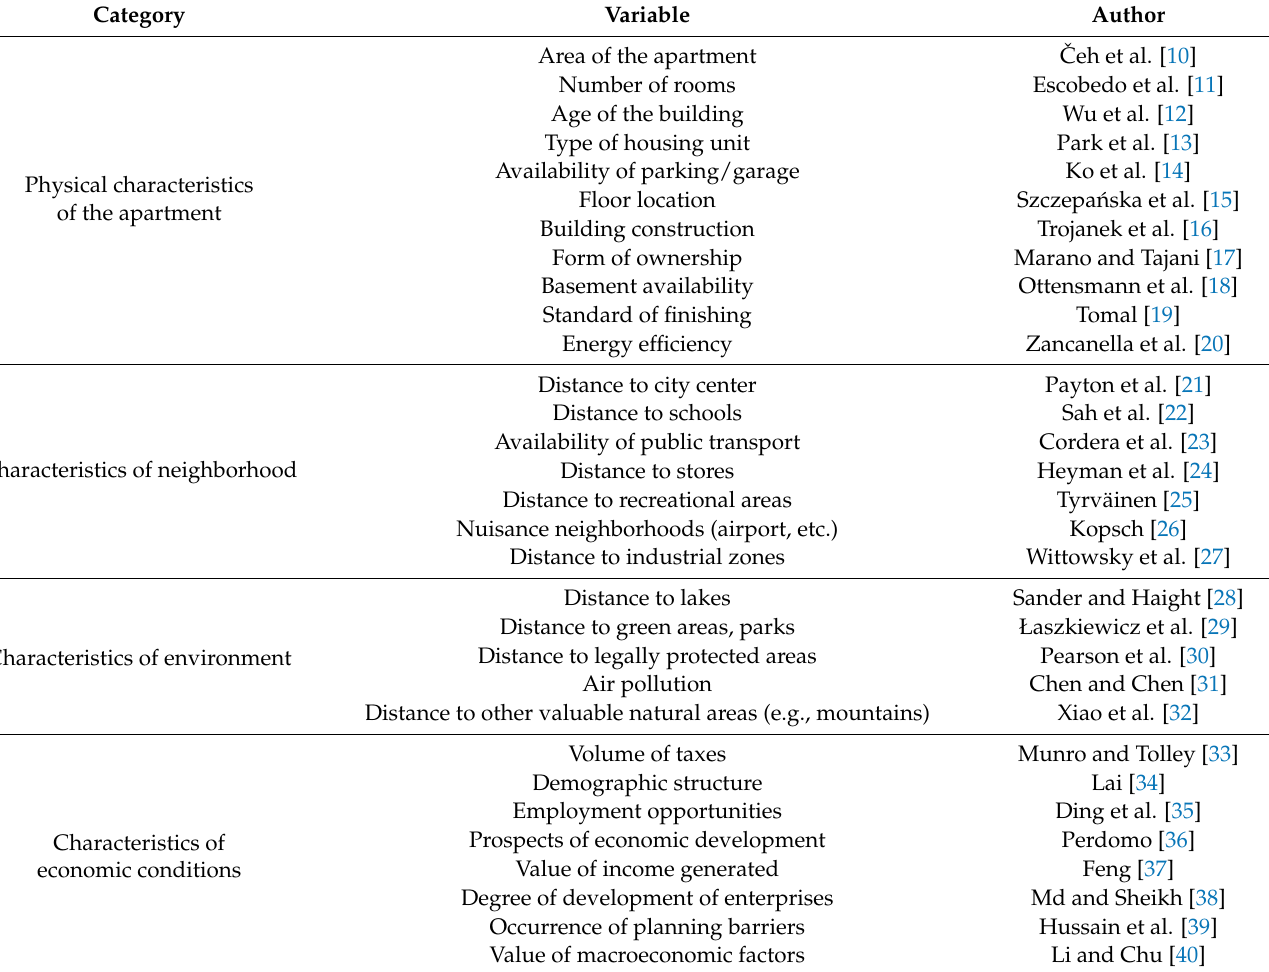
Table 1. Attribute categories based on the